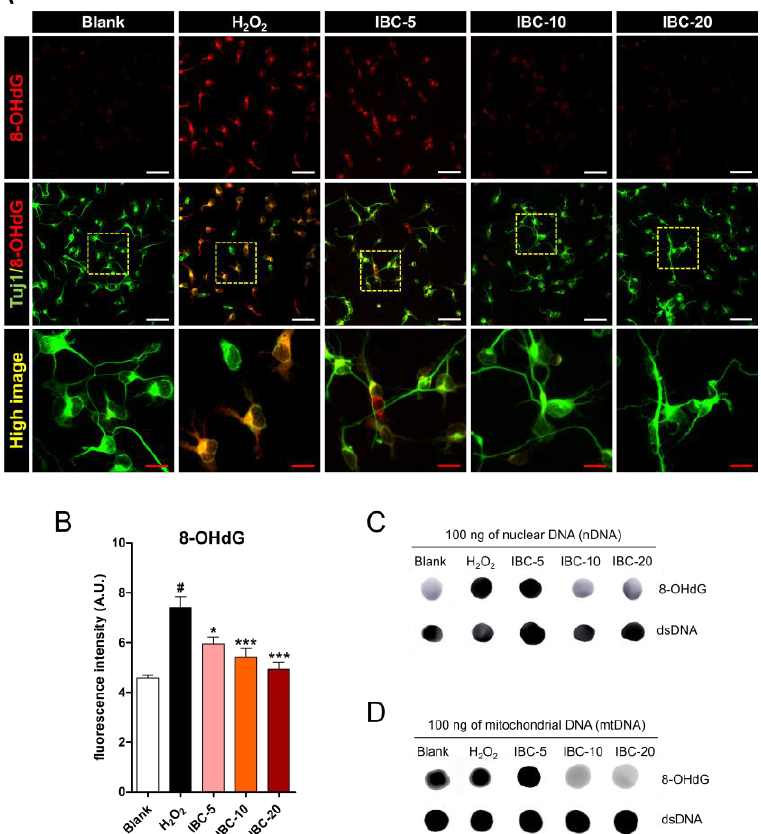
Figure 4. Effect of IBC extract on H 2 O 2 -induced oxidative stress-related DNA damage in rat primary cortical neurons. ( A , B ) Representative images ( A ) and quantitative analysis ( B ) showing the degree of oxidation in DNA stained with 8-OHdG for all five groups (n = 7). White scale bar = 50 µ m, Red scale bar = 15 µ m. ( C , D ) Representative dot blot images of 8-OHdG levels in nuclear DNA (nDNA) and mitochondrial DNA (mtDNA). Data are expressed as the means ± SEM. Significant differences indicated as # p < 0.001 compared vs. the blank group, * p < 0.05 and *** p < 0.001 vs. the H 2 O 2 group were analyzed via one-way ANOVA with Tukey’s post hoc